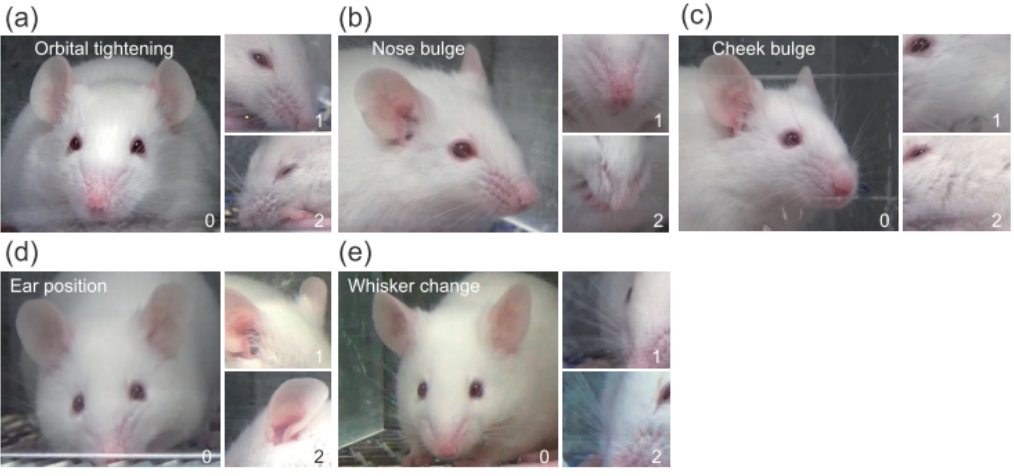
Figure 1. Five MGS action units and the scoring system. Each of the five action units, namely orbital tightening ( a ), nose bulge ( b ), cheek bulge ( c ), ear position ( d ), and whisker change ( e ), were scored using a three-level scale (i.e., 0, 1, or 2). A higher score suggests the scorer had stronger confidence in observing the painful facial expression of